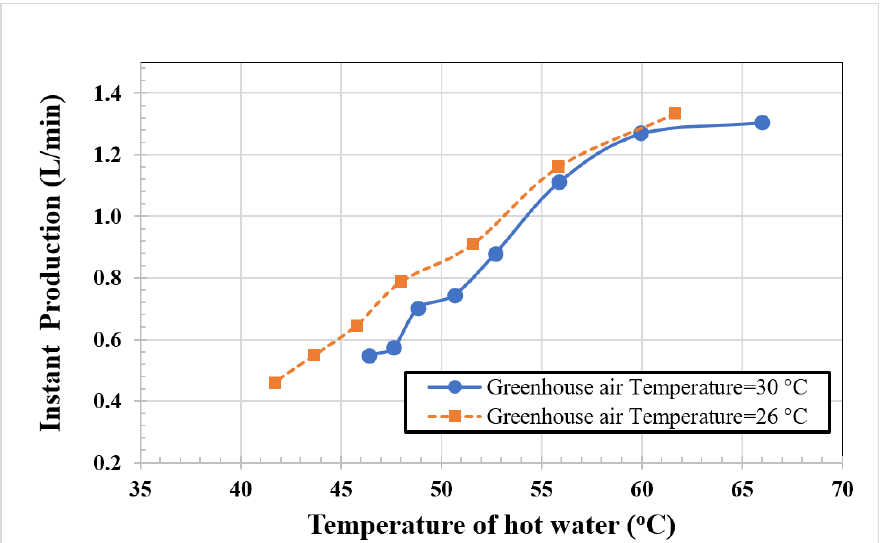
Figure 10. Instantaneous production of fresh water versus the temperature of the seawater at two different levels of the greenhouse air temperature.